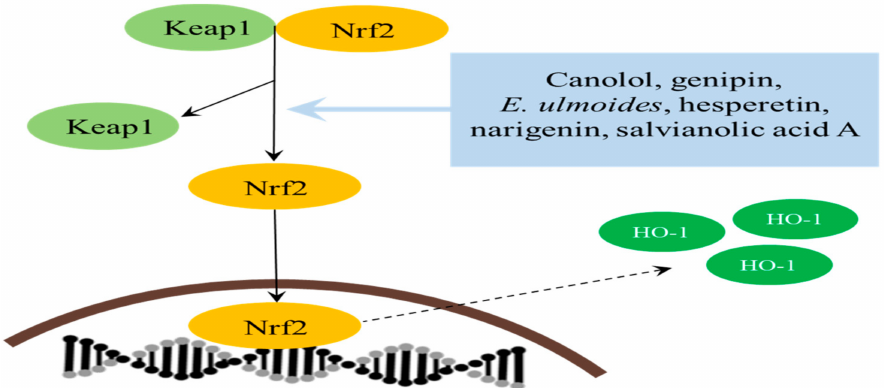
Figure 2. The anti-oxidative mechanism of natural products through the Nrf2/HO-1-ARE system. Nrf2 and the Keap 1 complex are dissociated by ERK/JNK/p38MAPK signals, and Nrf2 enters the nucleus in order to function as an HO-1 transcription factor. This ARE system is initiated by several natural products, such as canolol, genipin, Eucommia ulmoides , hesperetin, narigenin, and Saliva miltiorrhiza . Nrf2, nuclear factor erythroid 2-related factor 2; HO-1, heme oxygenase-1; ARE, antioxidant response element; Keap 1, Kelch-like ECH-associated protein 1; ERK, extracellular signal- regulated kinase; JNK, c-Jun N-terminal kinase; and p38MAPK, p38 mitogen-activated protein